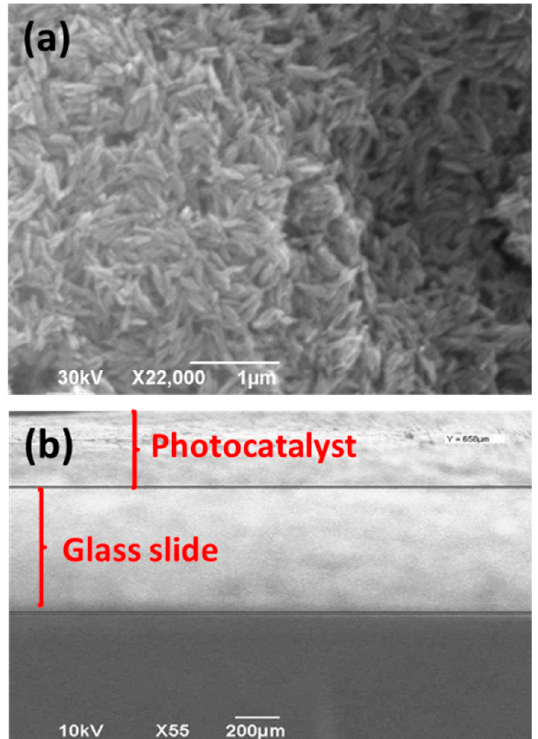
Figure 2. SEM images of the immobilized ZnO photocatalyst ( a ) top view and ( b ) cross sectional view.